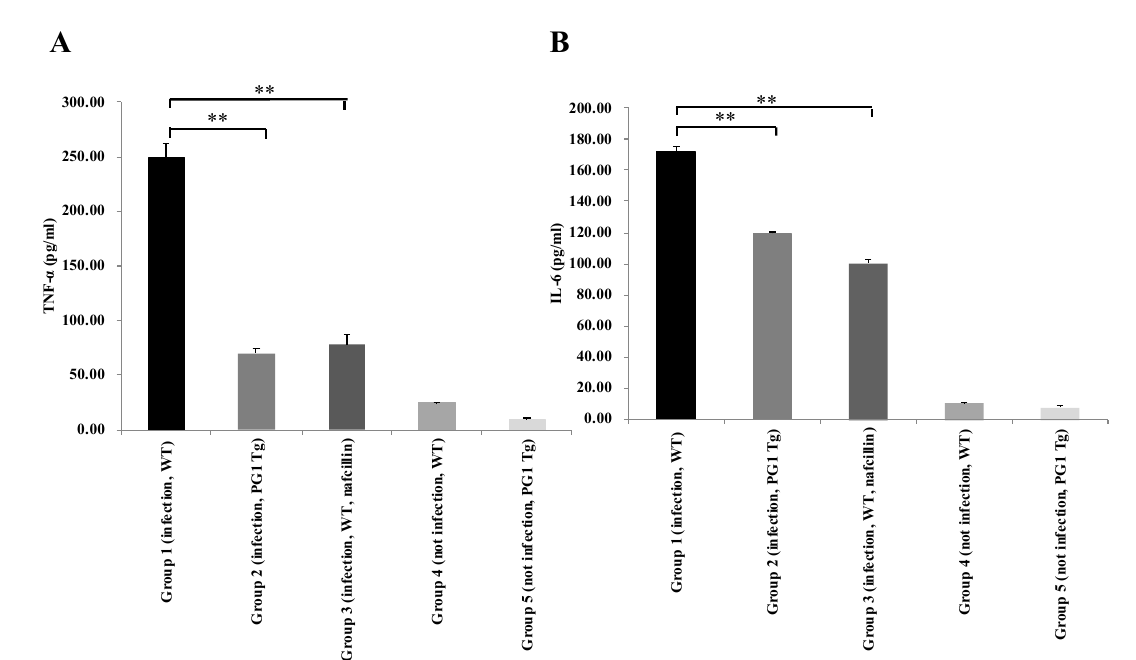
Figure 1. Comparison of the level of TNF- α and IL-6 secretion in the lung between wild-type and PG1 transgenic mice 48 h after Staphylococcus aureus infection. Except for groups 4 and 5, all other groups were challenged intranasally with S. aureus. The measured levels of TNF- α ( A ) and IL-6 ( B ) using ELISA assays were indicated. The symbol ** indicates p -value < 0.01. WT, wild-type; Tg, transgenic; Group 4, the control group.